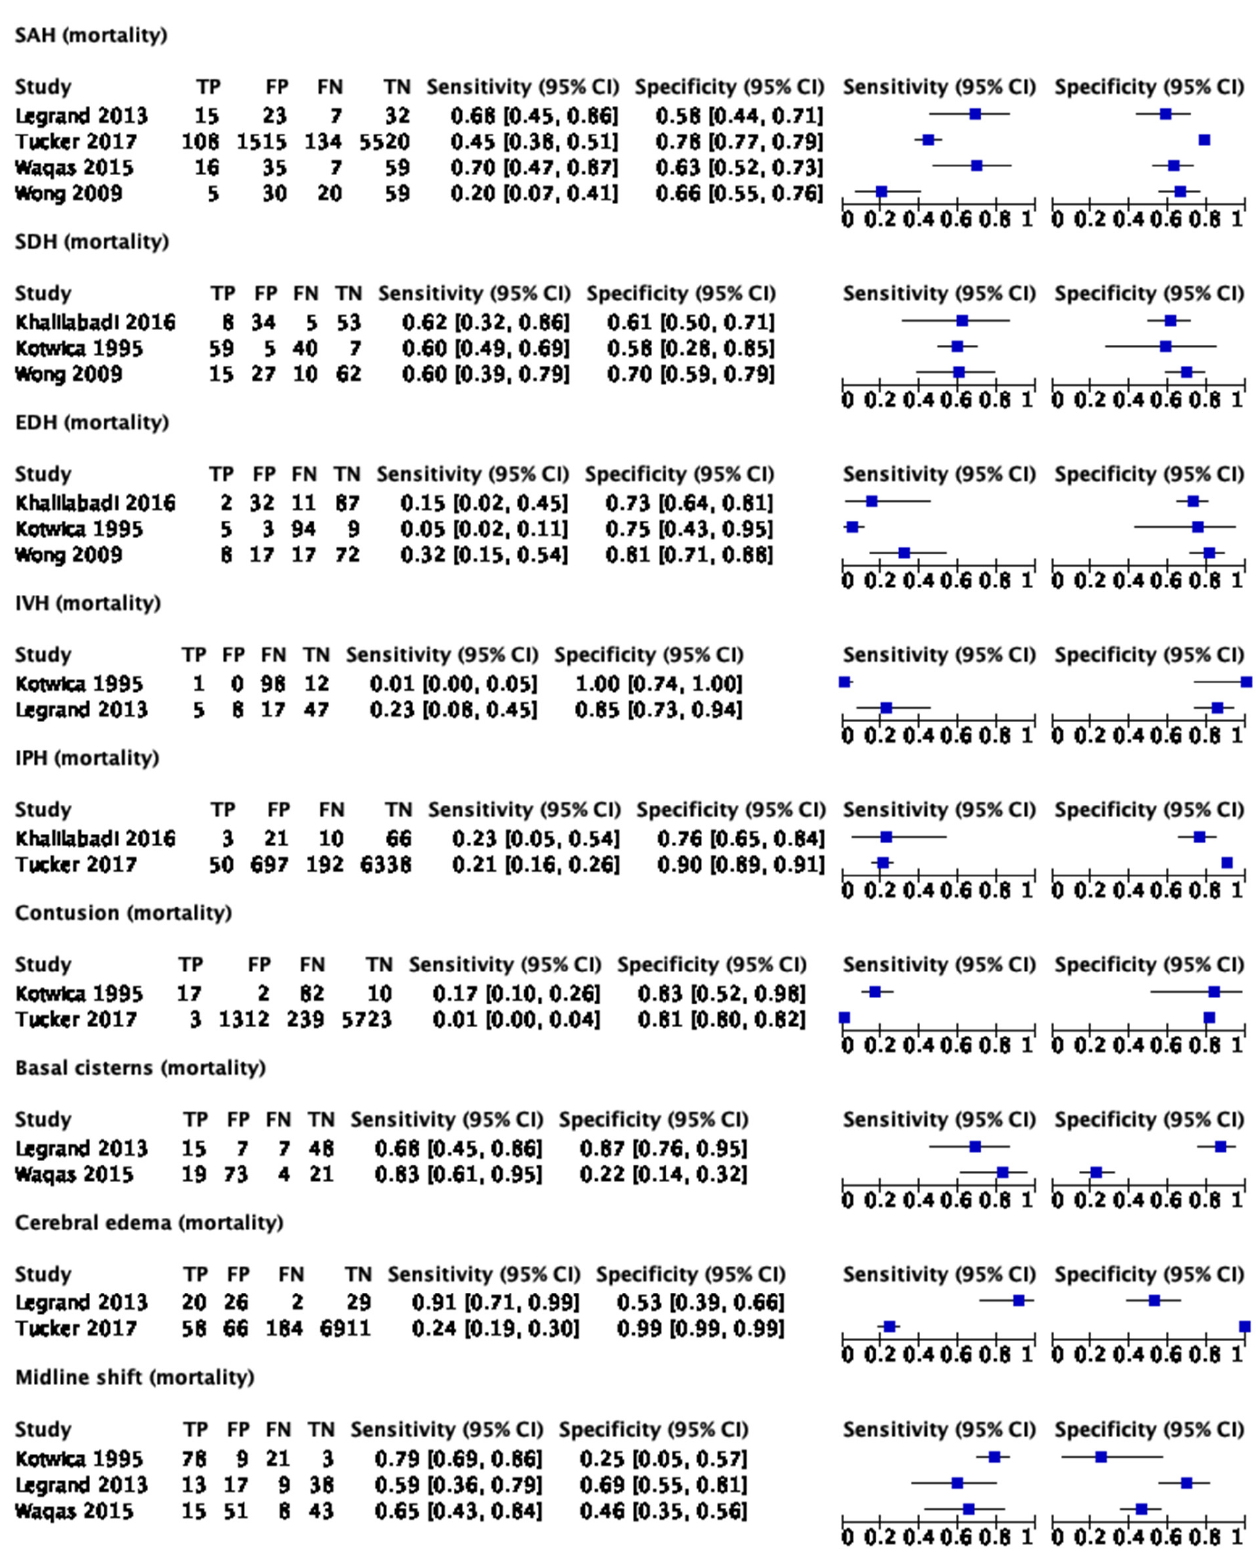
Figure 3. Forest plots for imaging findings and mortality in all TBI patients [22,23,25,33,34,36]. TP: true positive; FP: false positive; FN: false negative; TN: true negative.